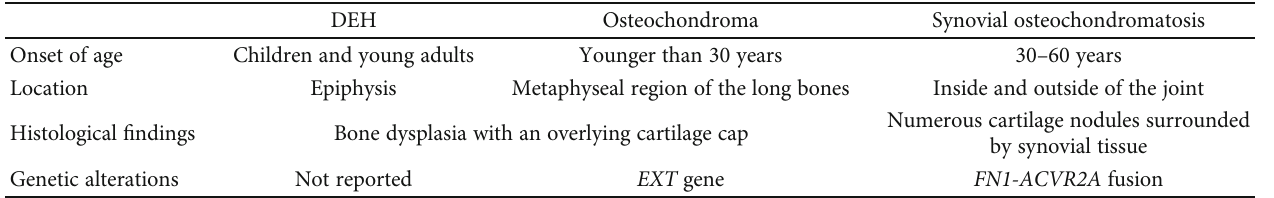
Table 2: Di ff erential diagnosis of